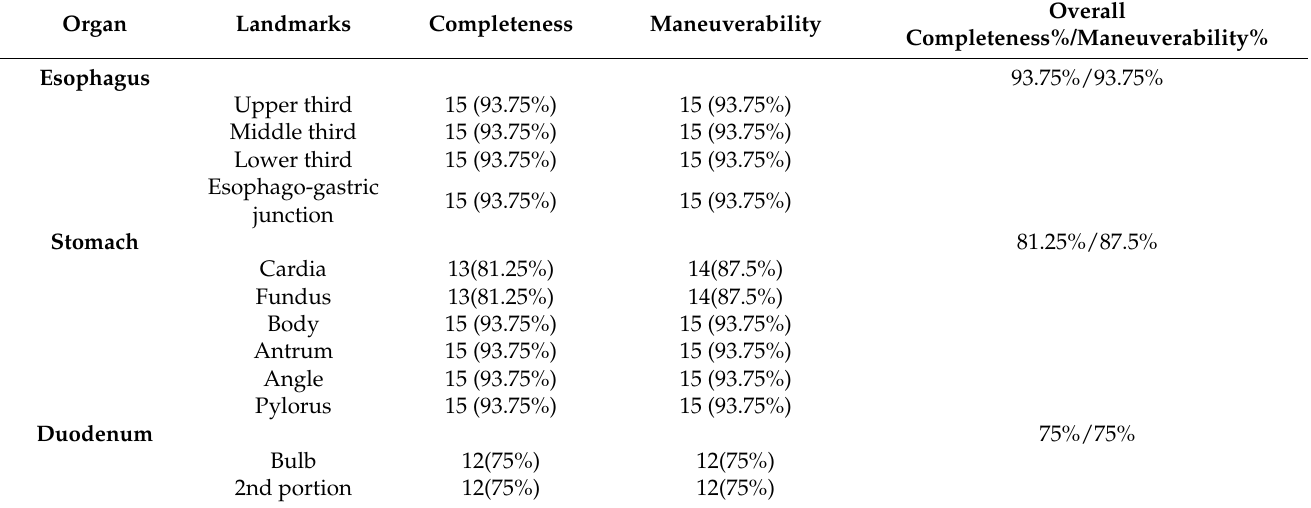
Table 2. Completeness and maneuverability of MACE for important landmarks of upper gastrointestinal tracts. Complete- ness was calculated as the number of landmarks observed divided by the number of landmarks that should be observed for a specific organ. Maneuverability was calculated as the number of landmarks reached by the capsule divided by the number of landmarks that should be reached in a particular